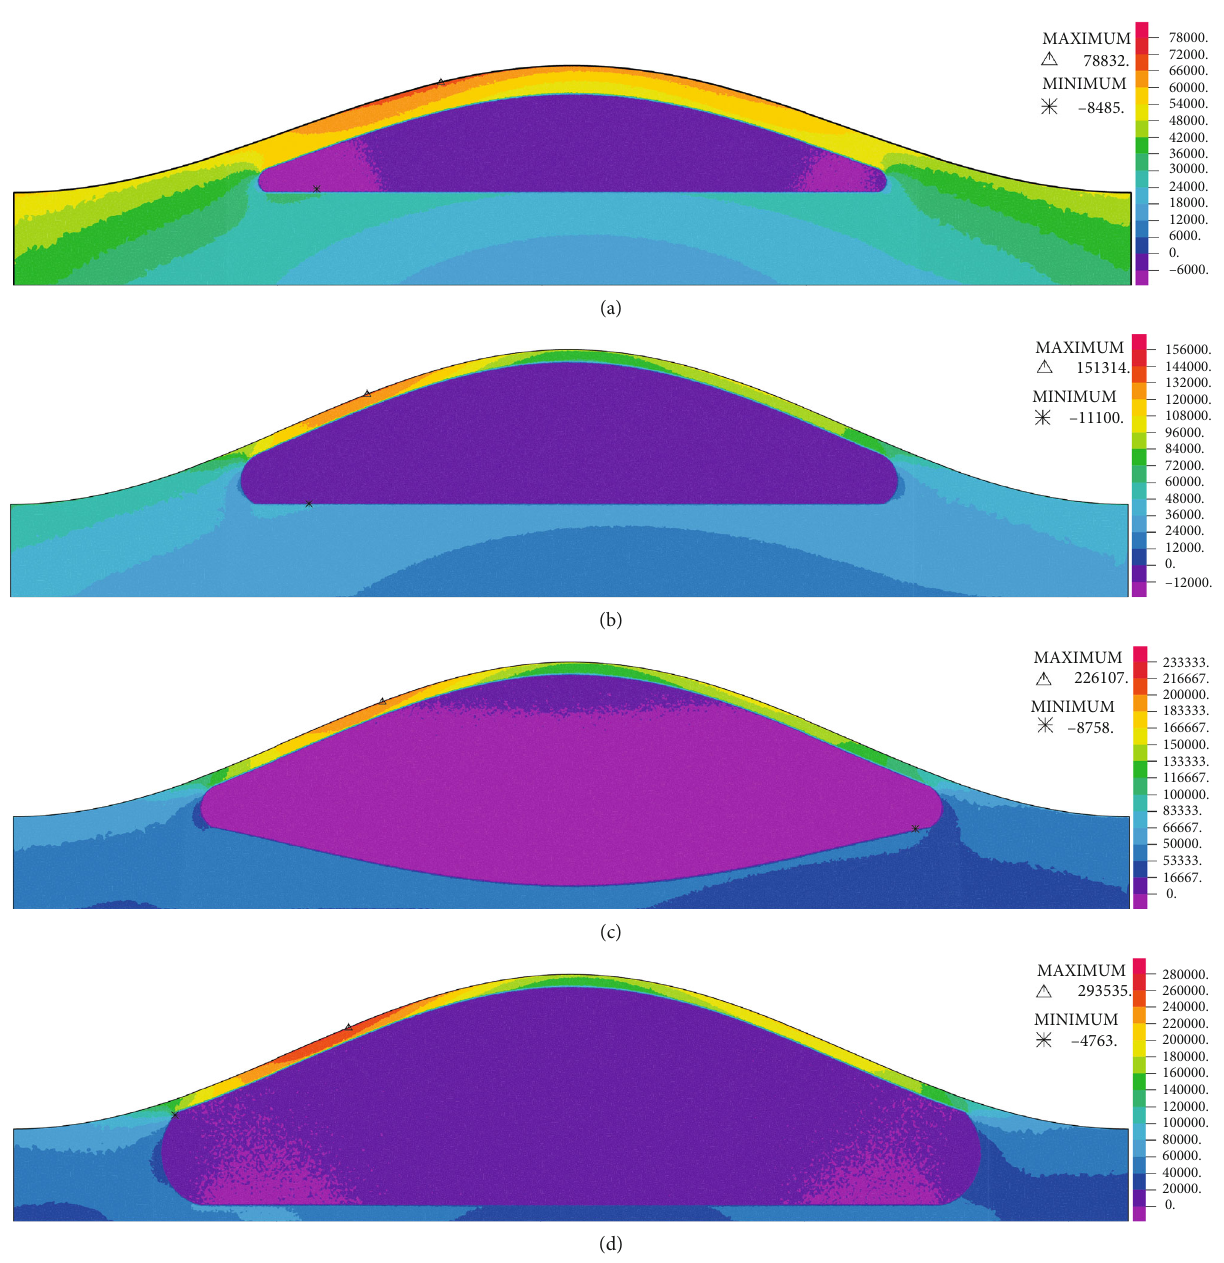
Figure 8: Circumferential wall stress (Pa) for (a) G1 (b) G2 (c) G3 (d) G4 models with 70% stenosis. Table 6: Maximum circumferential wall stress, mean value and coe ffi cient of variance at peak fl ow rate.